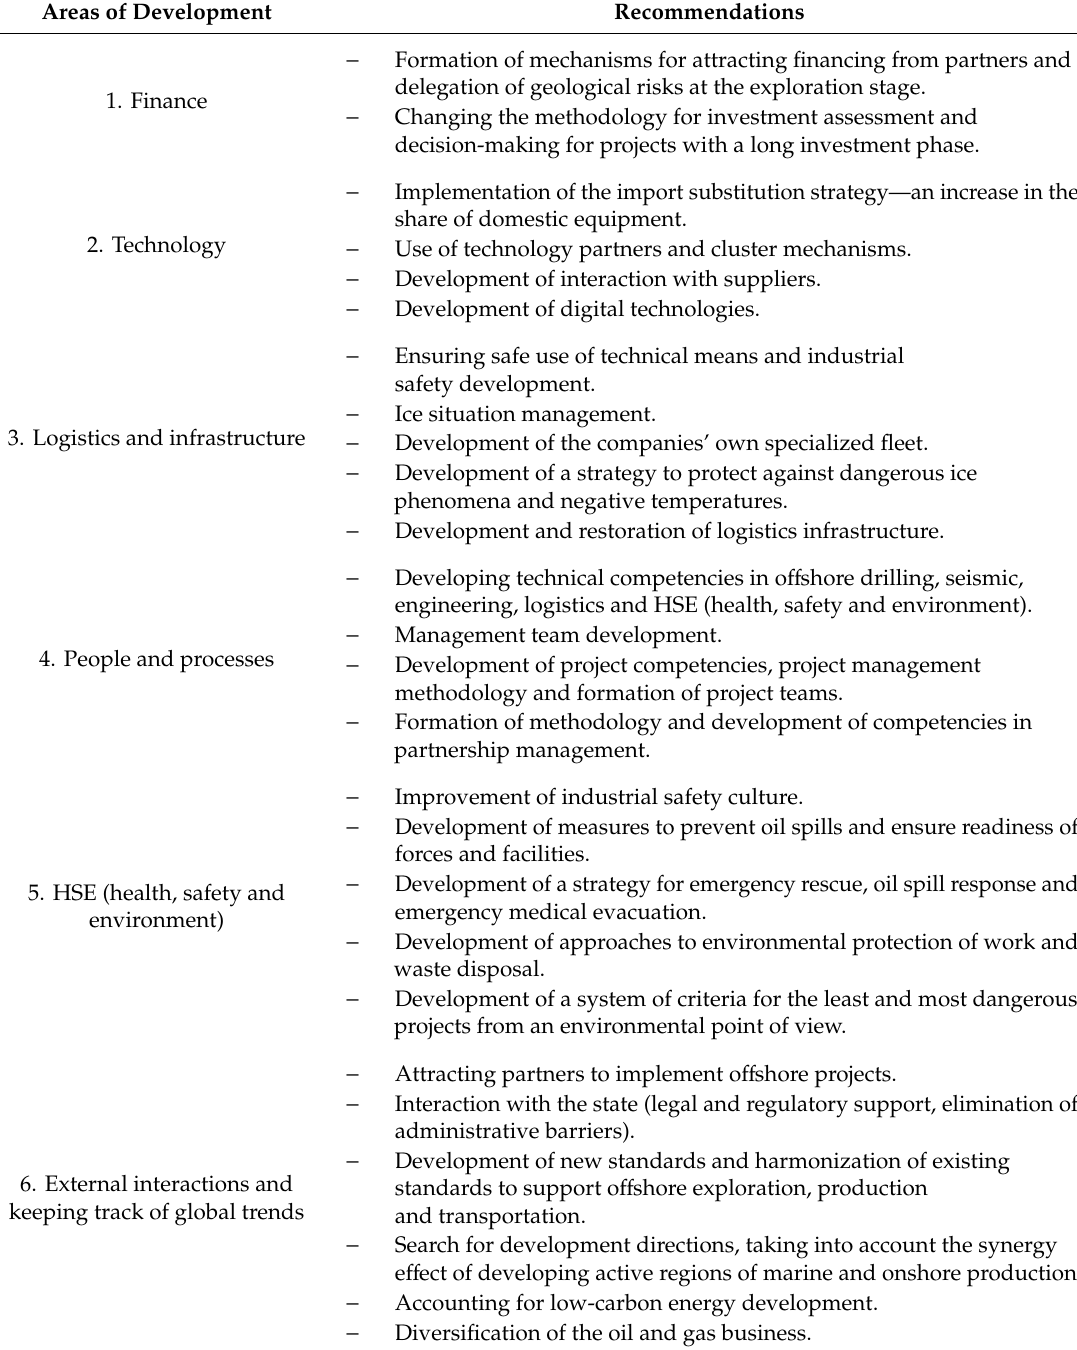
Table8. Developmentofo ff shoreprojectstofurtherdefinecriteriaforstrategicsustainabilityassessment. Areas of